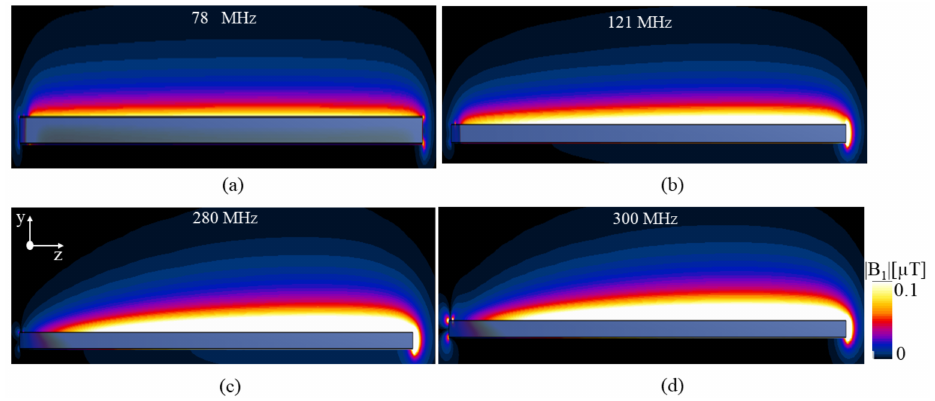
Figure 8. The y-z plane |B 1 | field and localization at each line for ( a ) 78, ( b ) 121, ( c ) 280, and ( d ) 300 MHz.